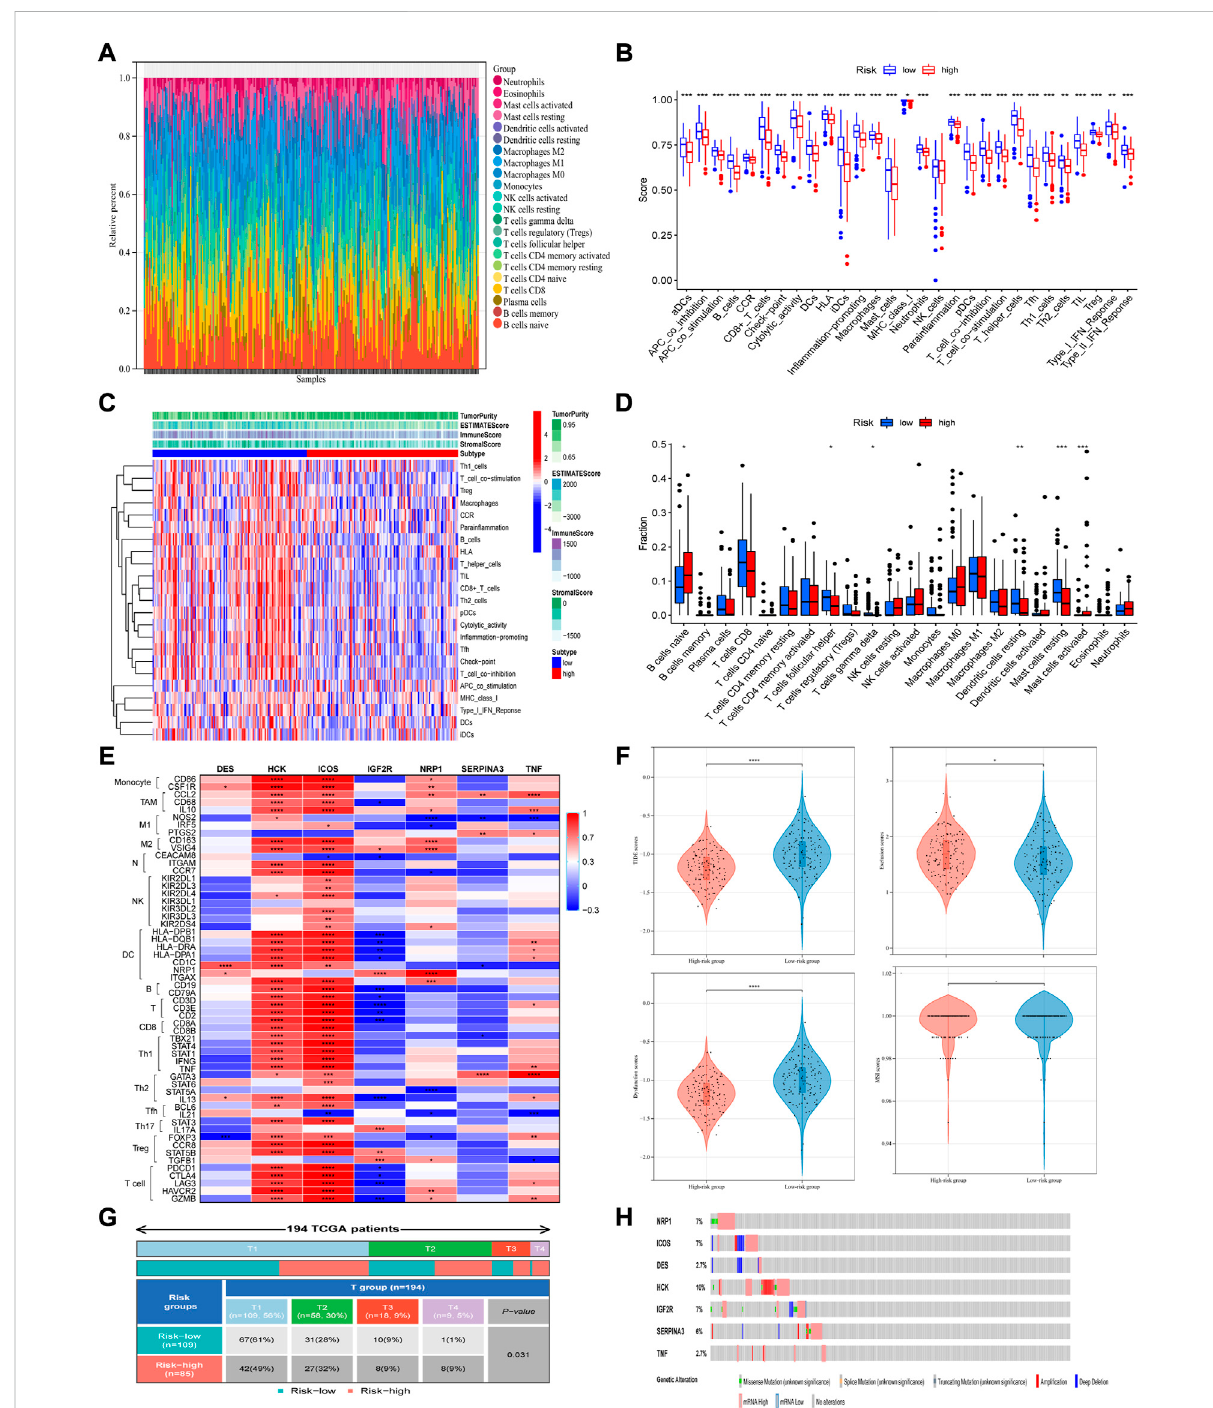
FIGURE 6 Immune cell in fi ltration analysis and related mutation analysis based on the signature. (A) The fraction of 22 immune cell types in total was analyzed with the use of CIBERSORT algorithm. (B) The immune functions were studied based on the ESTIMATE algorithm. (C,D) Both heatmap and boxplot showed the proportions of in fi ltrated immune components. (E) Expression of each candidate gene and its associated markers of immune cells. (F) The signature can perform better risk strati fi cation of patients with different stages of tumor. (G) TIDE prediction was conducted in the whole TCGA-CSCC set, which analyzed from four aspects respectively: TIDE scores, Exclusion scores, dysfunction scores and MSI scores (from left to right, top to bottom). (H) Mutation analysis was performed using the cBioPortal online